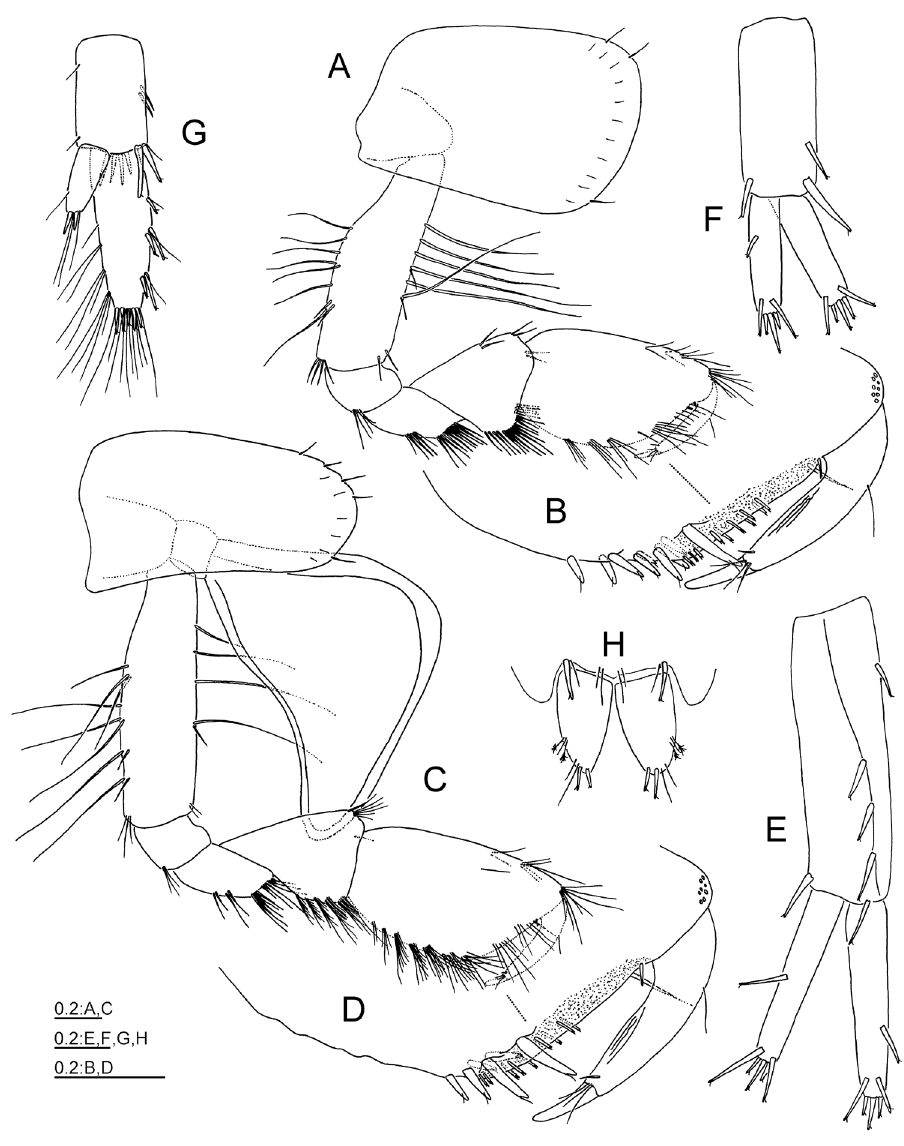
Figure 3. Zenkevitchia yakovi sp. n.: holotype, male (10.0 mm), X43382/Cr-1613-FEFU. A Gnathopod 1, lateral view B Enlarged palmar part of gnathopod 1 C Gnathopod 2, lateral view D Enlarged palmar part of gnathopod 2 E, F, G Uropods 1–3, dorsal views H Telson, dorsal along ventral margin, 4 setae along posterior margin. Epimeral plate 3 : postero-ventral corner acuminate; posterior margin slightly concave; ventral margin convex; 4 notched spines along ventral margin, 3 setae along posterior margin. Telson width : length ratio is 1 : 0.85; cleft 0.9 of length; only 2 sub-apical spines per lobe present, these